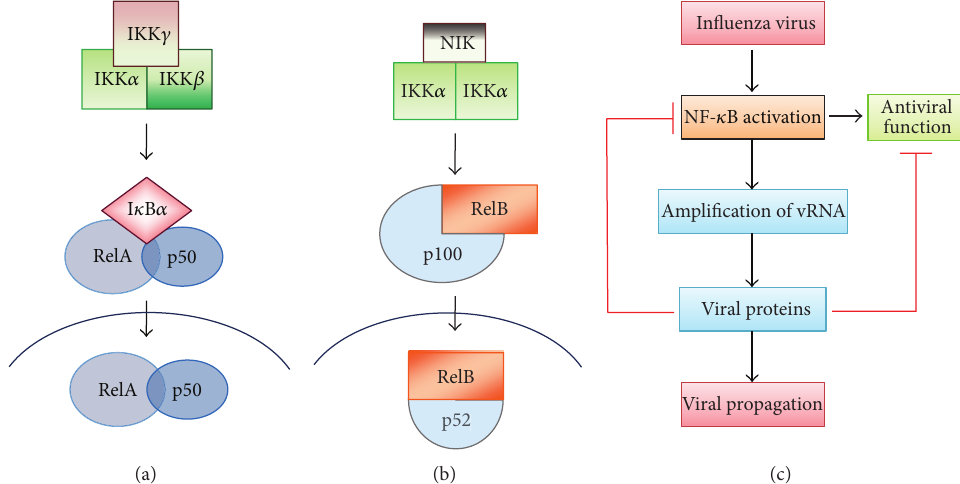
Figure 4: NF- 𝜅 B signaling pathway and its regulation by influenza virus. (a) The canonical pathway involves activation of the IKK complex, IKK-mediated I 𝜅 B 𝛼 phosphorylation, and subsequent degradation, resulting in nuclear translocation of the heterodimer RelA(p65)/p50. (b) The noncanonical pathway is dependent on phosphorylation-induced p100 processing. This leads to activation/translocation of the RelB/p52 complex. (c) Influenza virus activates the NF- 𝜅 B pathway to facilitate the amplification of vRNAs and production of progeny viruses. Newly synthesized influenza viral proteins antagonize the activation of NF- 𝜅 B signaling and inhibit the function of antiviral proteins or immunoregulatory molecules induced by the